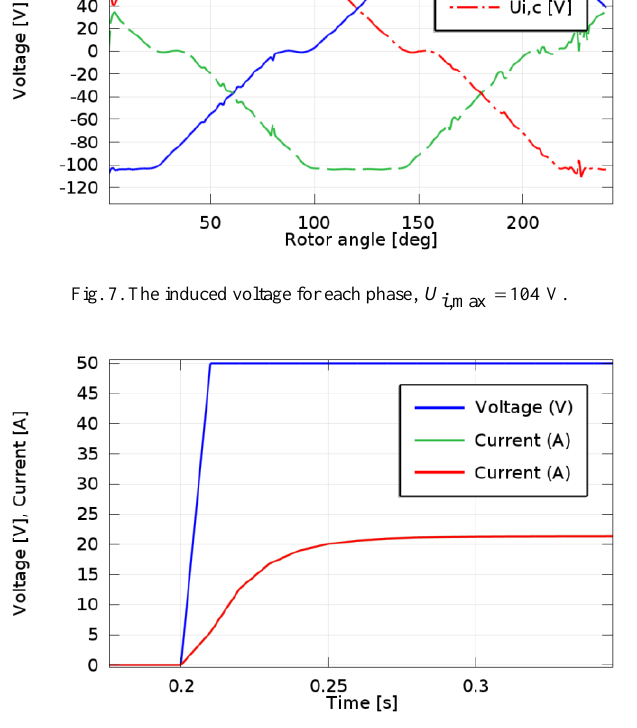
Fig. 8. The voltage excitation is a step function. The time transient currents are overlapping, which means that the machine is round rotor, i.e. L d = L q . The time constant T can be read from the figure, 04 . 0  T